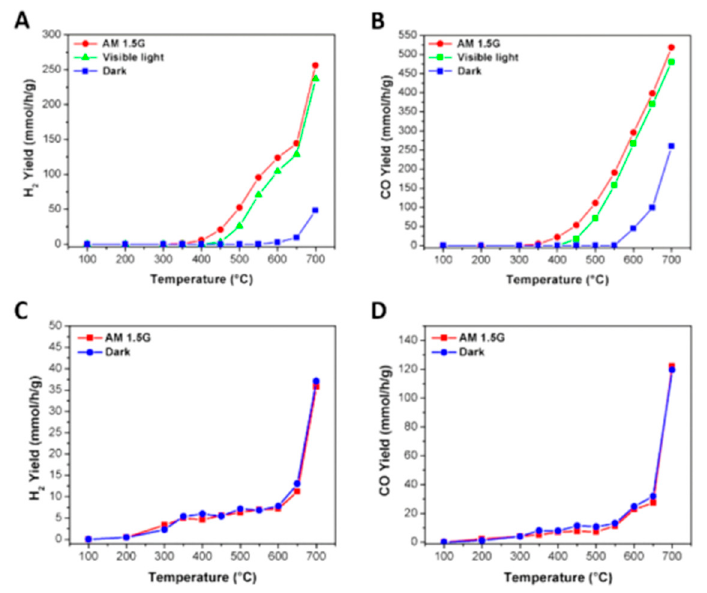
Figure 30. Yield of ( A ) H 2 and ( B ) CO for DRM using Pt/black TiO 2 under AM 1.5G (the global standard spectrum), visible light, and dark conditions, and ( C ) H 2 and ( D ) CO using Pt/Al 2 O 3 as a reference. Reprinted with permission from [50]. Copyright (2015), American Chemical Society.